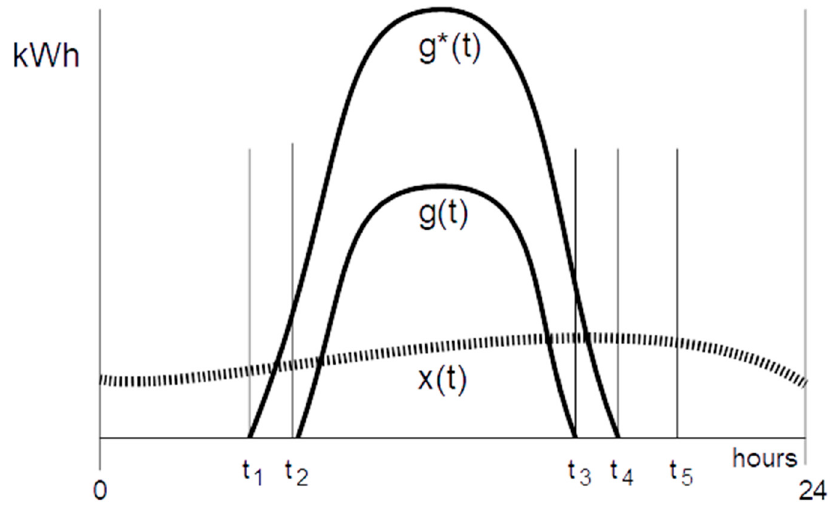
Figure 2. Adjusting the power of a prosumer plant. Source: Own elaboration